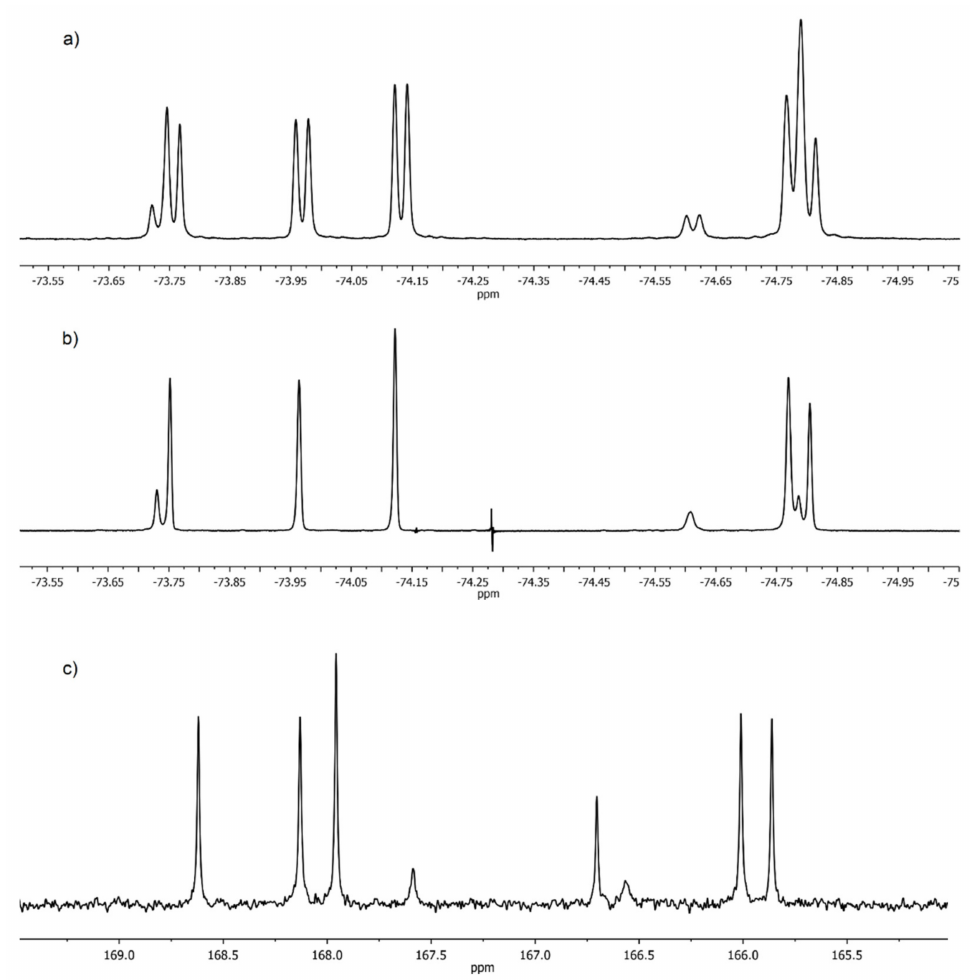
Figure 2. ( a ) 19 F NMR spectrum; ( b ) 19 F–{ 1 H}–NMR spectrum; ( c ) Carbonyl part of 13 C NMR of 1 in CDCl 3 at 23 ◦ C.